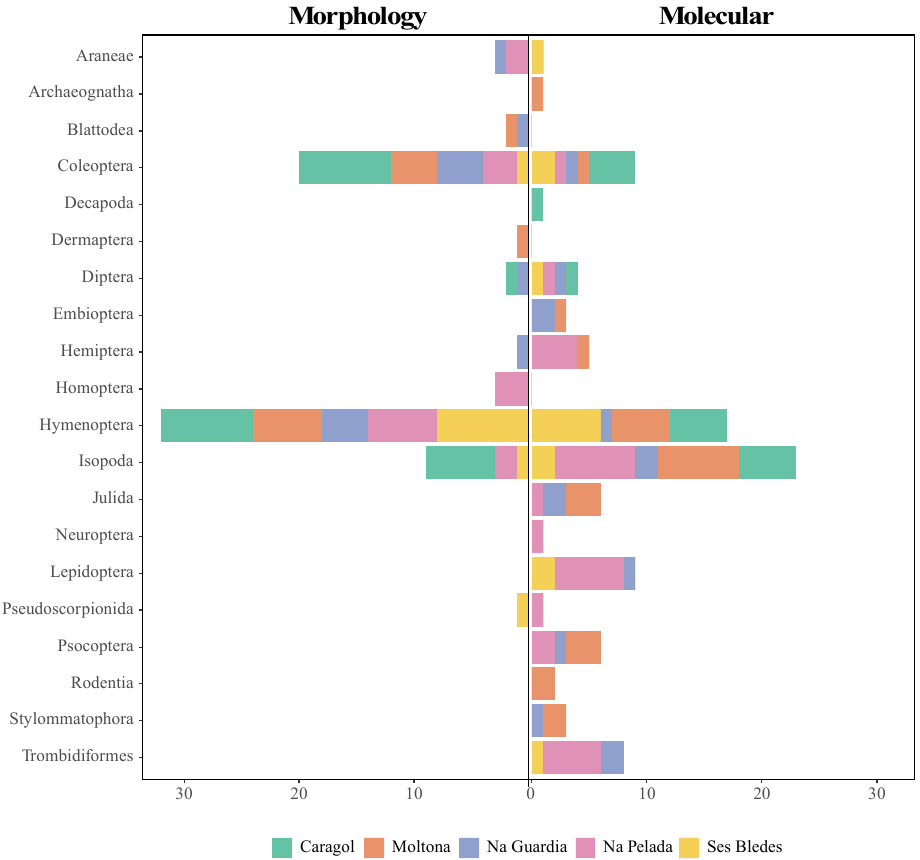
Figure 2. Frequencies of occurrence of each order of animals in the diet composition of Podarcis lilfordi through morphological and molecular analysis.